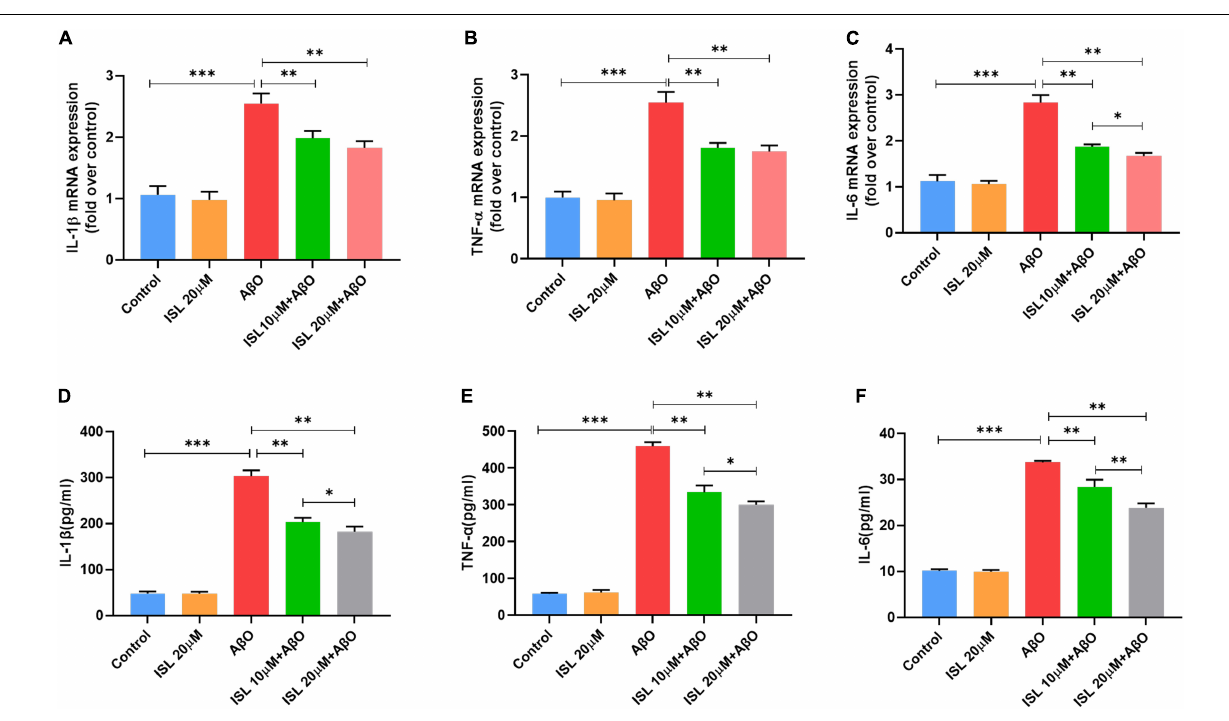
FIGURE 2 | ISL inhibited the production of pro-inflammatory cytokines in BV2 cells induced by A β O. (A–C) BV2 cells were pre-treated with ISL for 2 h and then co-treated with 5 µ M A β O for 6 h. The mRNA levels of IL-1 β , IL-6, and TNF- α in BV2 cells treated with A β O in the presence or absence of ISL were analyzed by qRT-PCR. (D–F) BV2 cells were pre-treated with ISL for 2 h and then co-treated with 5 µ M A β O for 24 h. The production of TNF- α , IL-6, and IL-1 β in BV2 cells treated with A β O in the presence or absence of ISL were determined by ELISA. ∗ p < 0.05, ∗∗ p < 0.01, ∗ ∗ ∗ p < 0.001. n = 6 per